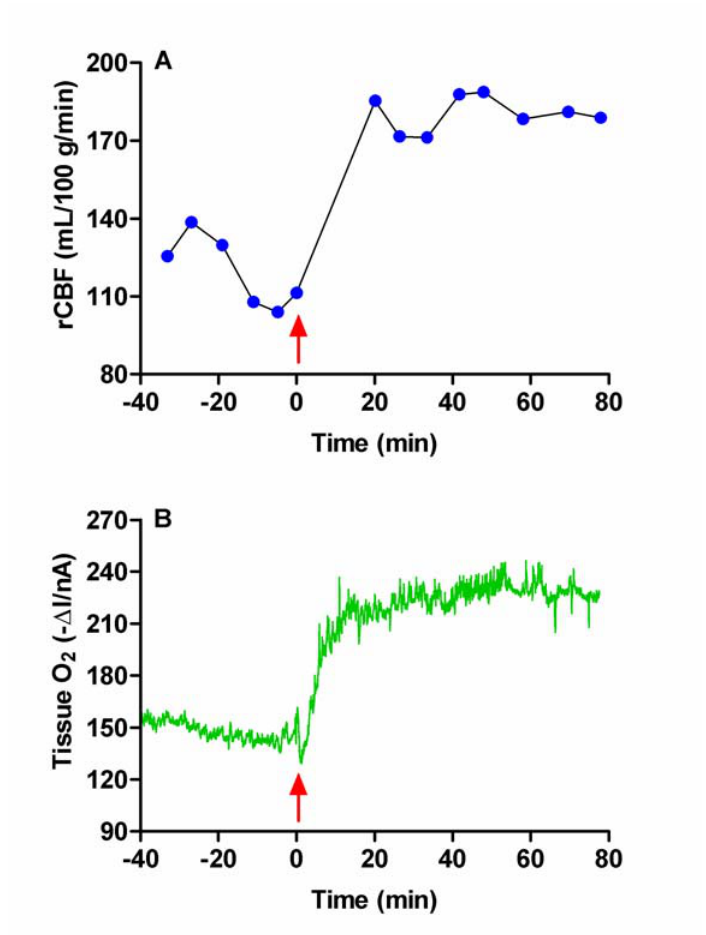
Figure 5. The effects of systemic administration of the carbonic anhydrase inhibitor acetazolamide (Diamox, 50 mg/kg, i.p.) on the tissue O 2 and blood flow (rCBF) levels monitored simultaneously with bilaterally implanted carbon paste (O 2 ) and Pt/Ir (H 2 clearance) electrodes in the striatum of a freely- moving